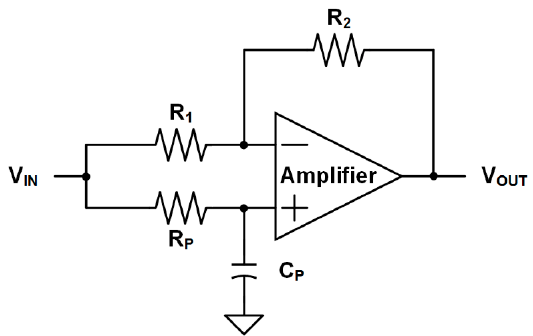
Figure 7. Schematic of the all-pass filter.